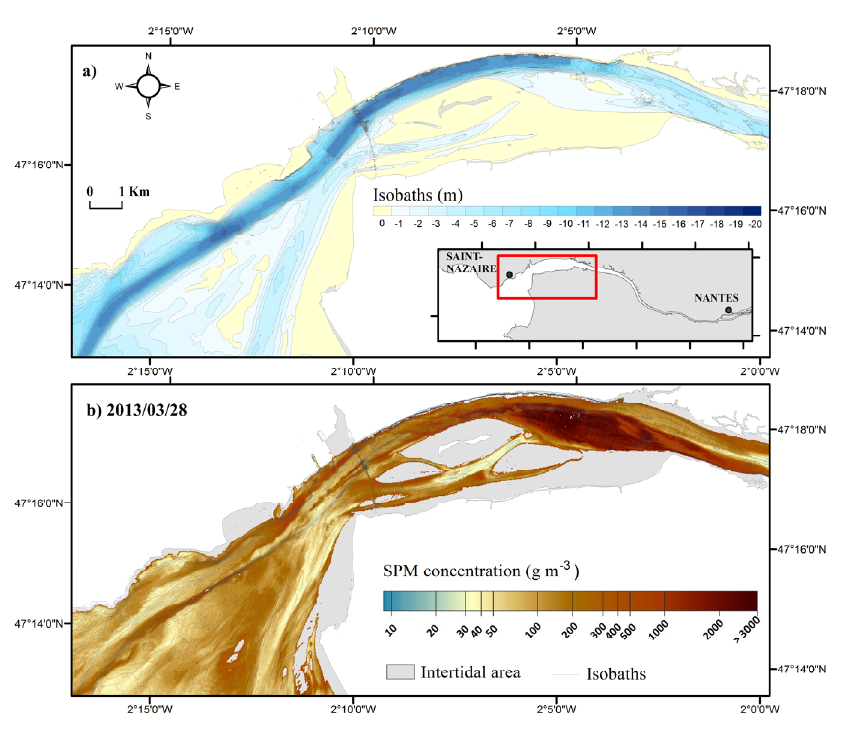
Figure 9. ( a ) Bathymetry of the Loire estuary’s outer section; ( b ) SPOT4 suspended particulate matter (SPM) concentration at low tide on 28 March 2013, superimposed to bathymetric contour